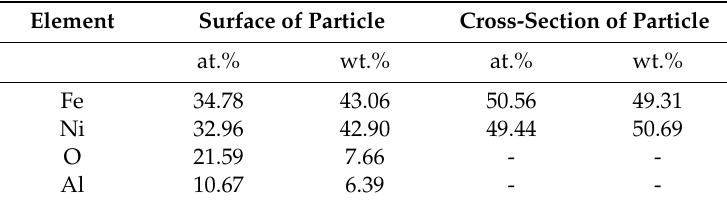
Table 1. Composition ratios of Fe and Ni in the spherical alloy sample.